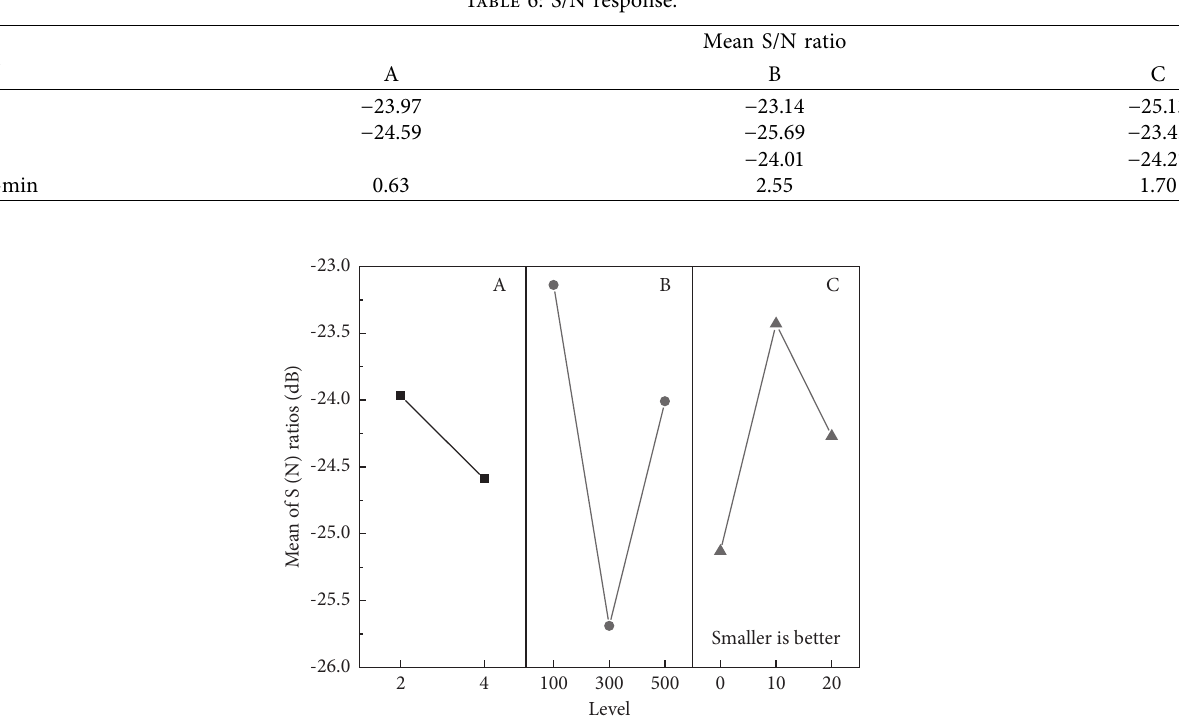
Figure 5: Main effect diagram of S/N for Table 7: ANOVA for RPDD.